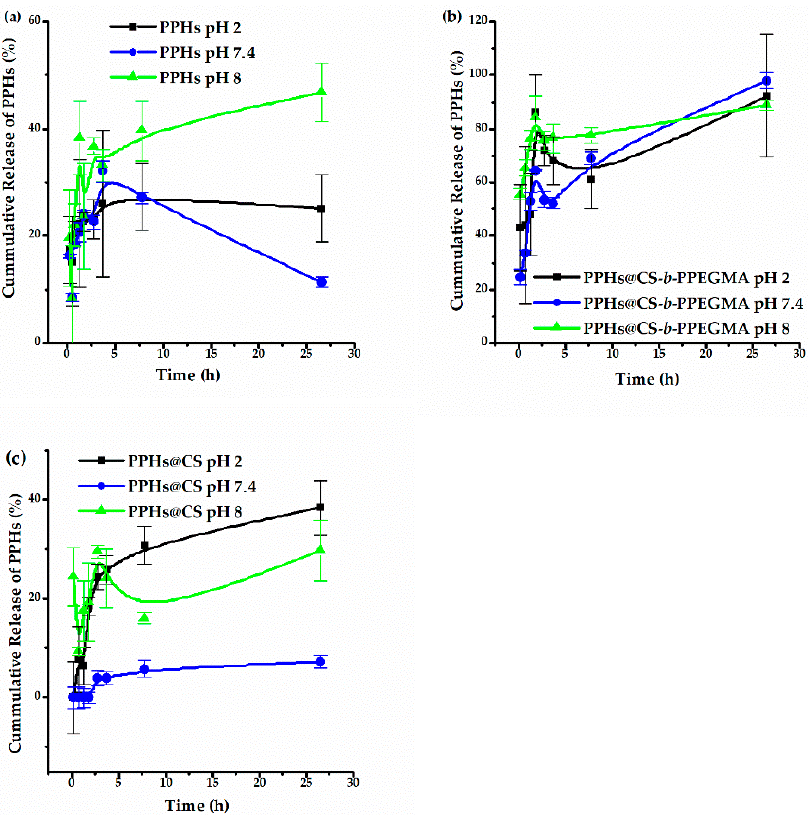
Figure 10. Release profiles of ( a ) PPHs, ( b ) PPHs@CS- b -PPEGMA, and ( c ) PPHs@CS. Values represent the mean ± standard deviation (n = 3).